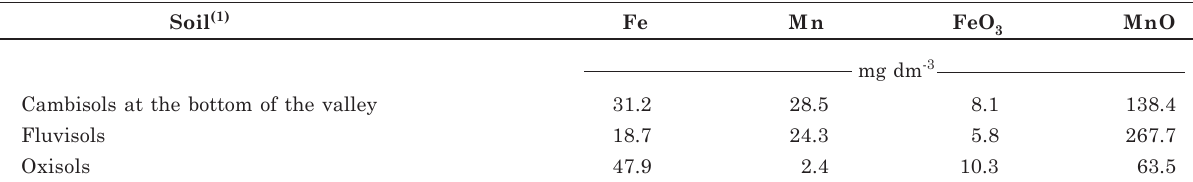
Table 2. Available Mn and Fe (Mehlich-1) and MnO and FeO 3 (total forms) contents in soils where eucalyptus shows high incidence of ESBVRD (Cambisols at the bottom of the valley and Fluvisols) and low incidence of this anomaly (Oxisols)